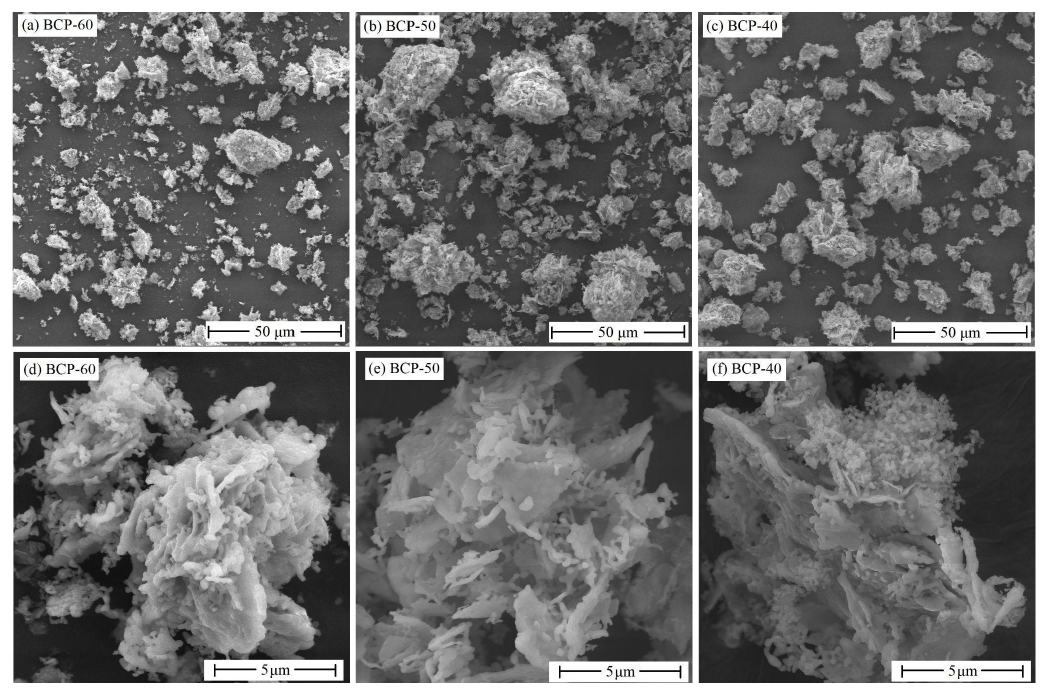
Figure 5. SEM of BCP-60, BCP-50, and BCP-40.